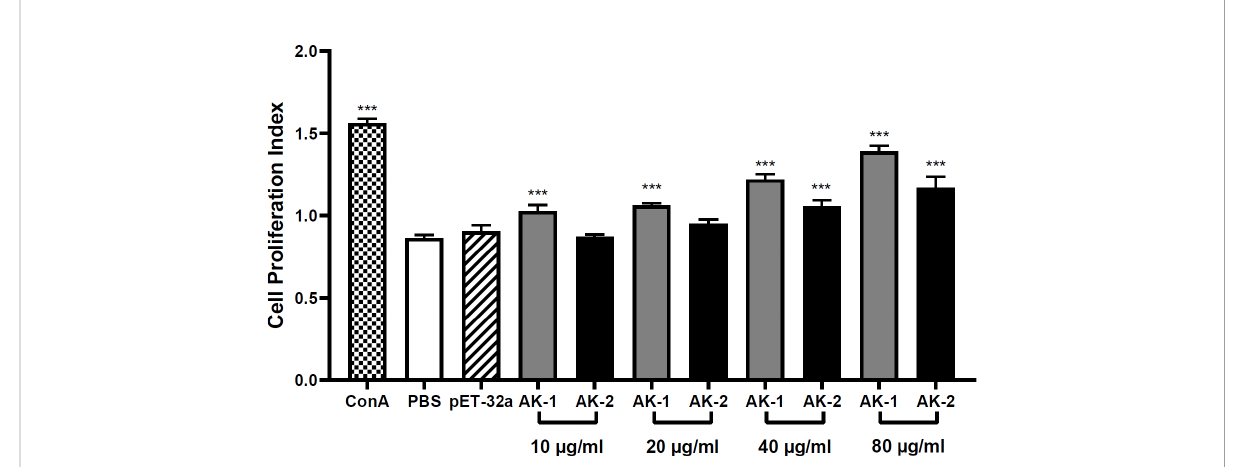
FIGURE 6 The effects of the rSsAKs on PBMC proliferation. CCK-8 detection of the effects of the rSsAKs on PBMC proliferation. The cell proliferation index was the optical density at 450 nm (OD450). Data are the mean ± SD of three replicates per group as compared to the PBS group. *** P <